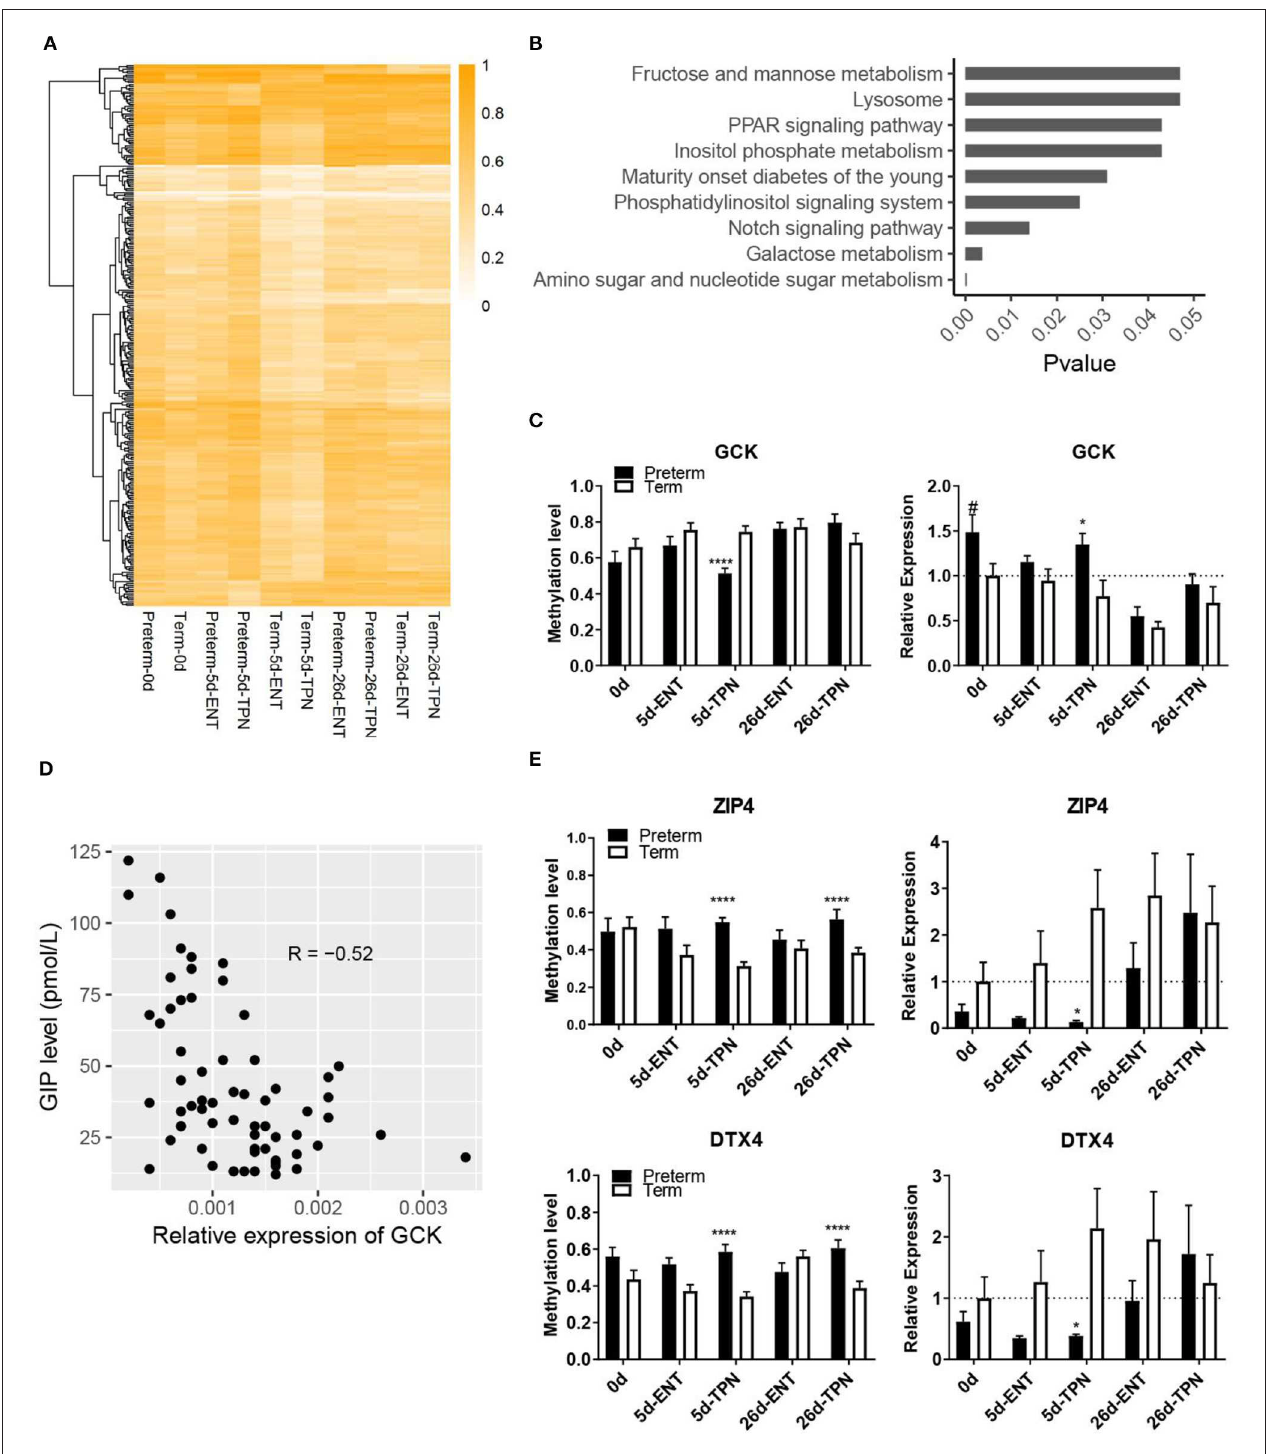
FIGURE 3 | Methylation differences between preterm and term intestines after birth. (A) Heatmap depicting methylation level of DMRs that present in postnatal period. Hierarchical clustering was performed using complete linkage method with euclidean distance. (B) KEGG pathways enriched from genes with TPN-specific DMRs. (C) Barplots showing methylation level of the DMR and mRNA expression of GCK. Values in barplots are presented as mean ± SEM. # P < 0.1, * P < 0.05, ** P < 0.01, *** P < 0.001. (D) Scatterplot illustrating the correlation between mRNA expression of GCK in the small intestine and plasma GIP level. (E) Barplots showing methylation level of the DMR and mRNA expression of ZIP4 and DTX4. Values in barplots are presented as mean ± SEM. * P < 0.05, ** P < 0.01, *** P < 0.001, **** P < 0.0001.